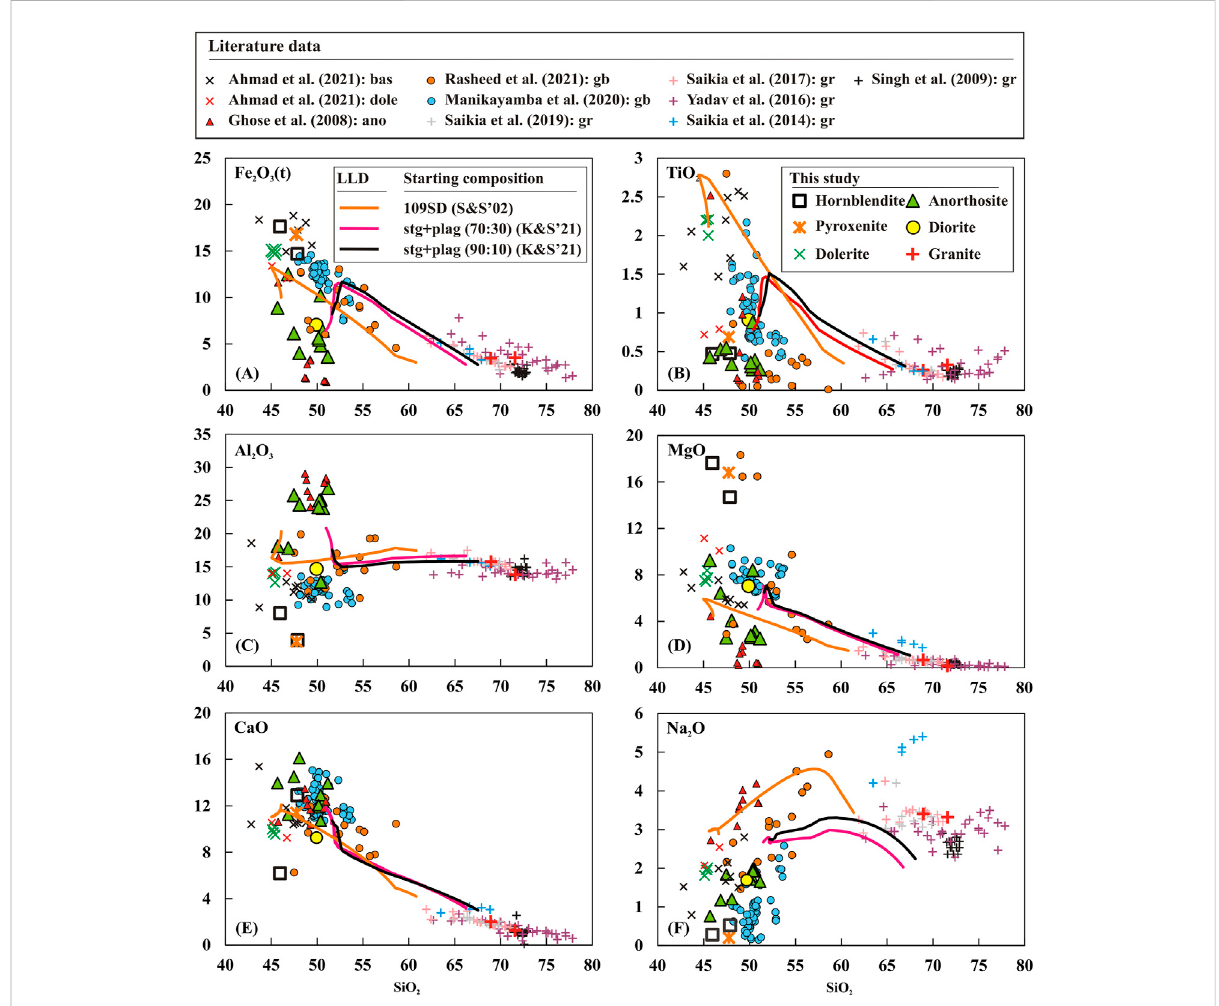
(Supplementary Figure S6), most trace elements of CGGC rocks appear to form two clusters, with SiO 2 = ~60 wt% forming the dividing line. Hornblendite, pyroxenite, basalt, dolerite, gabbro, and anorthosite rocks of CGGC cluster at SiO 2 < ~60 wt%, whereas granites cluster at SiO 2 > ~60 wt%. Rocks with SiO 2 < ~60 wt% are relatively more enriched in Ni, Sc, V, and Sr but depleted in Pb and Th than rocks with SiO 2 > ~60 wt% (Supplementary Figure S6). To test whether the two groups of rocks are genetically related, we made incompatible trace element ratio plots of Nb/Th vs. Zr/Sm and Sr/Y vs.